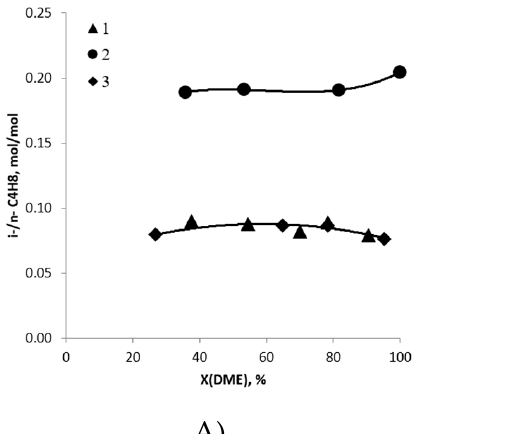
Figure 10. Hydrogen transfer index as a function of DME conversion (X (DME), %). 1—HZSM- 5/Al 2 O 3 ; 2—Zr- HZSM-5/Al 2 O 3 ; 3—Mg- HZSM-5/Al 2 O 3 . HTI for C 3 hydrocarbons—dashed line; HTI for C 4 hydrocarbons—solid line.